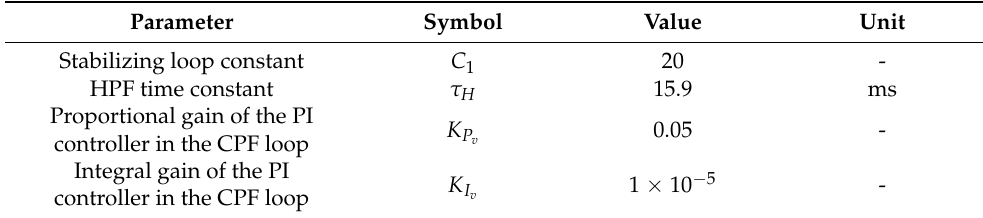
Table A3. Parameters for the Stable V / f control with CPF.